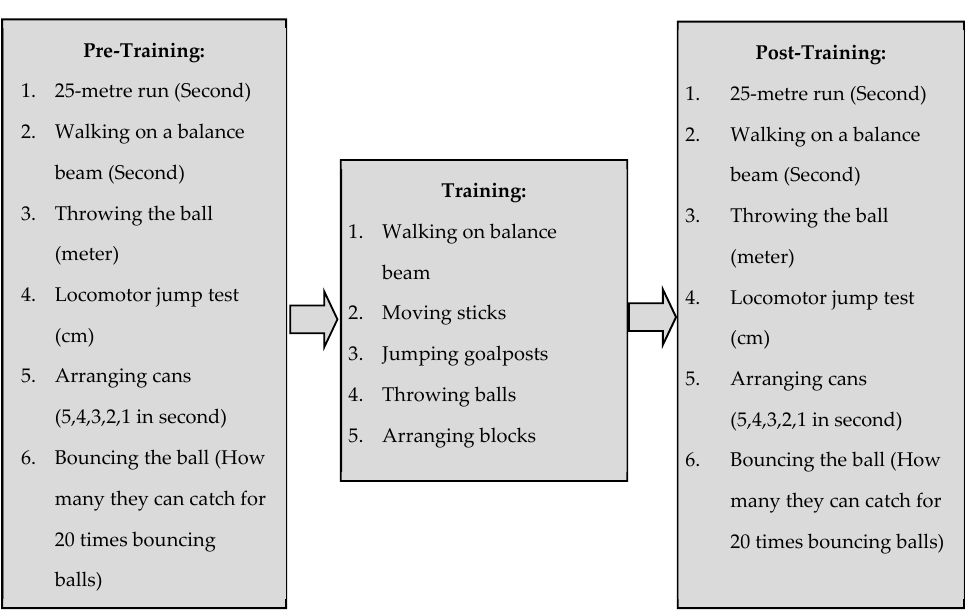
Figure 1. Pre- and post-data collection procedures.